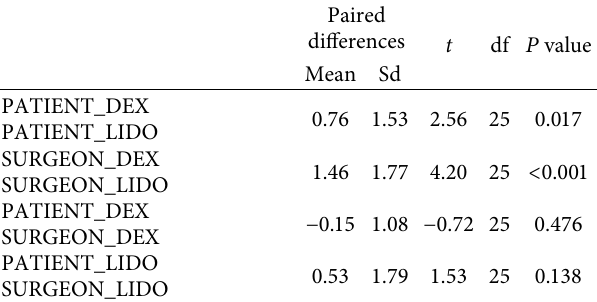
Table 4: Paired T -test results for VAS of patient’s and surgeon’s